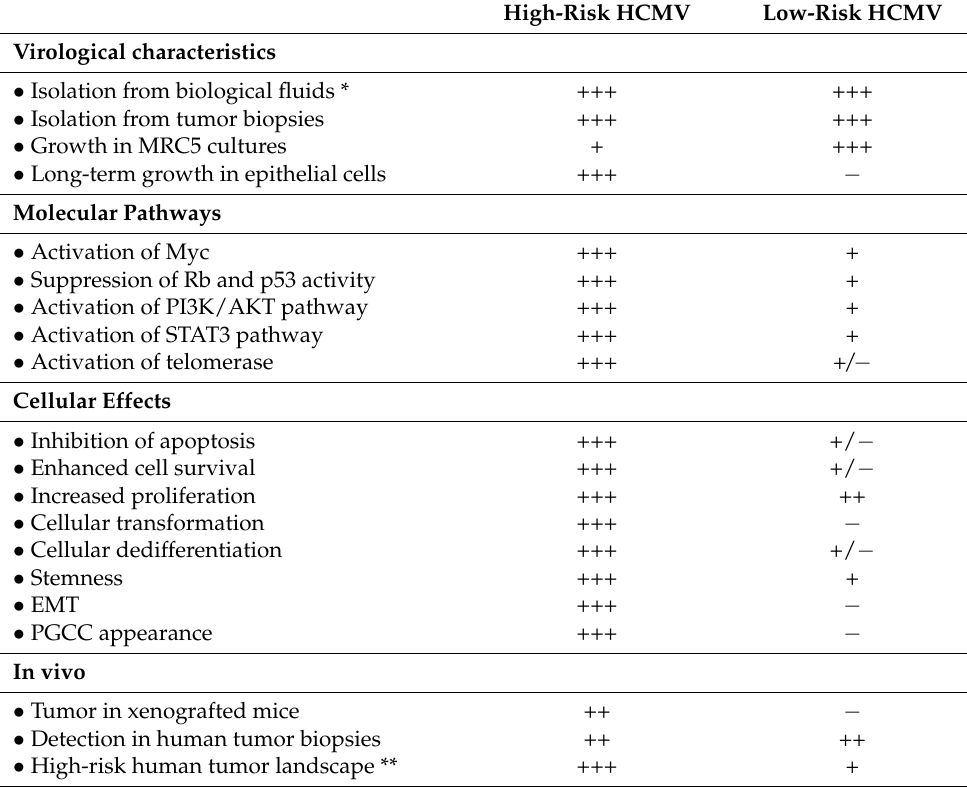
Table 1. Characteristics of HR and LR HCMV